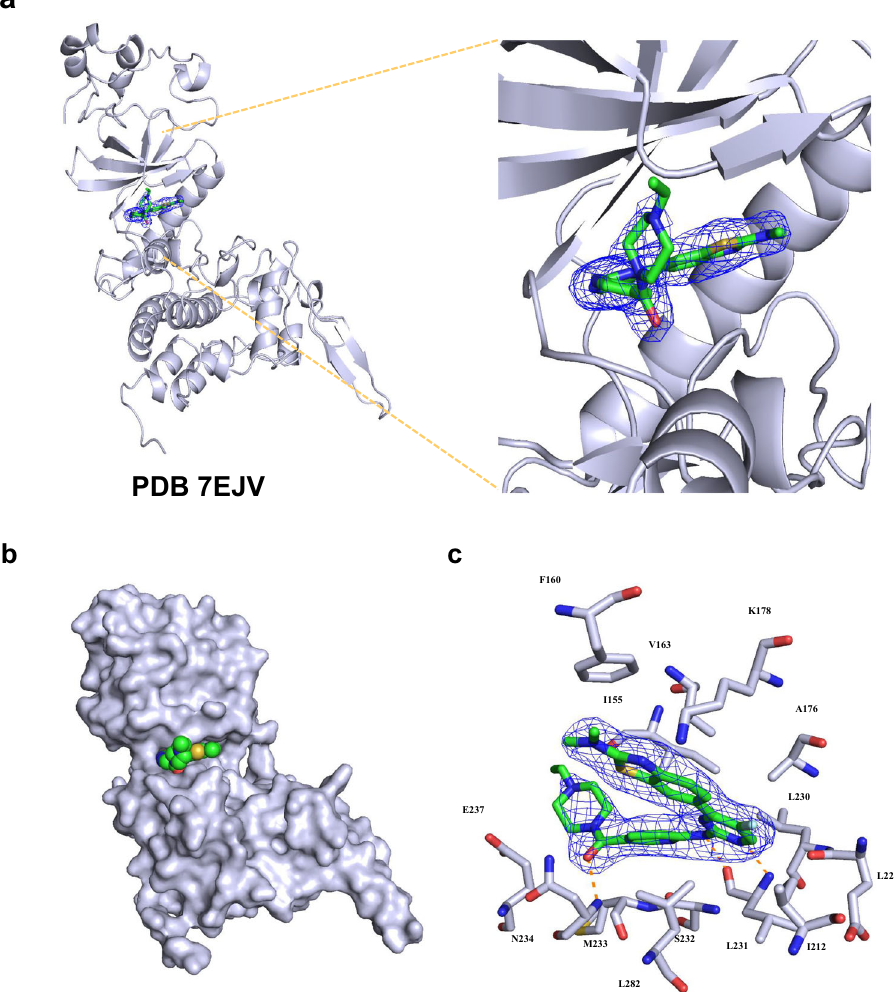
Fig. 4 Co-crystal structure of YK-2-69 with DYRK2. a The F O -F C omitted map is contoured at 3.0 σ and shown as a blue mesh, which reveals the presence of YK-2-69. DYRK2 is shown as ribbons. PDB ID: 7EJV. b YK-2-69 occupies the ATP binding pocket of DYRK2. DYRK2 is shown as surface, and YK-2-69 is shown as spheres. c Detailed interactions between YK-2-69 and DYRK2 in the co-crystal